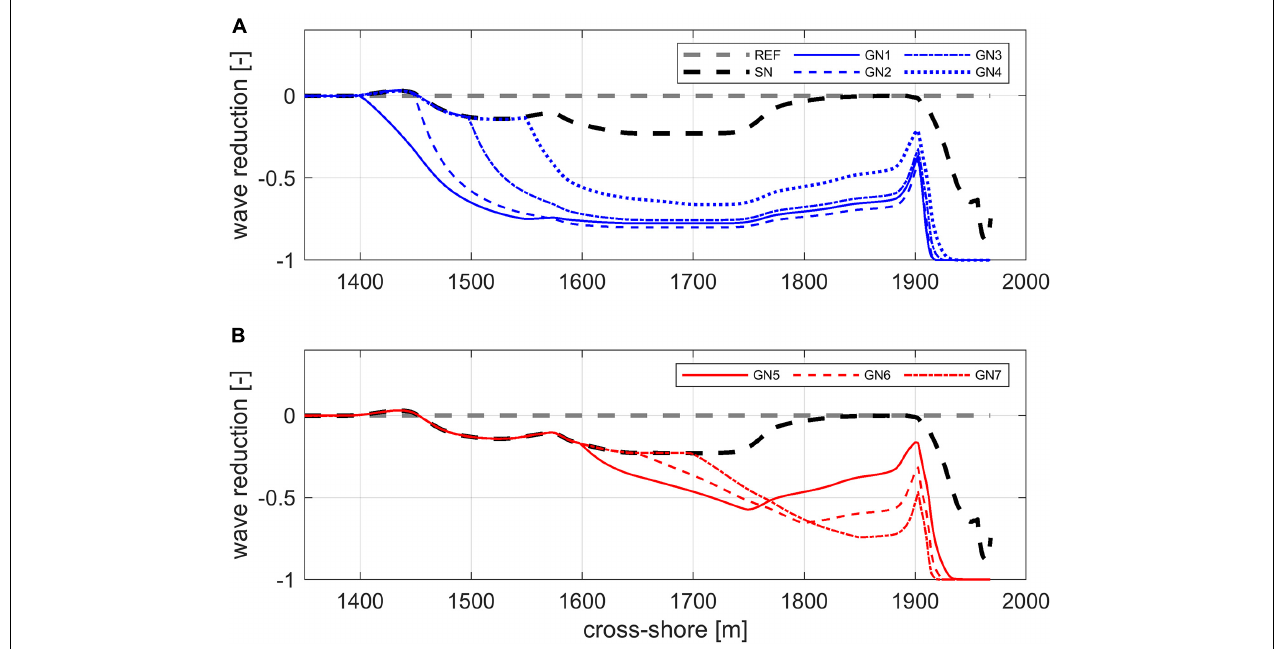
FIGURE 4 | Wave height reduction (i.e., wave height difference compared with the REF case) under mild wave for: (A) case SN, GN1-4; and (B) case GN5-7.